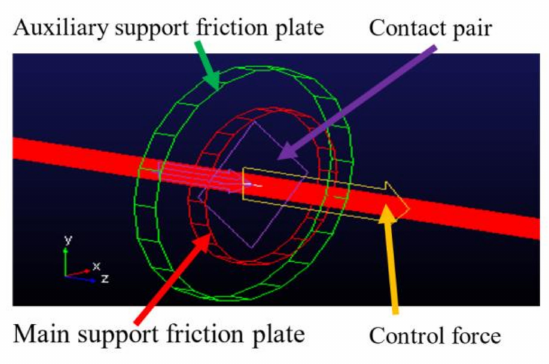
Figure 5. Realization of the Smart Spring function.